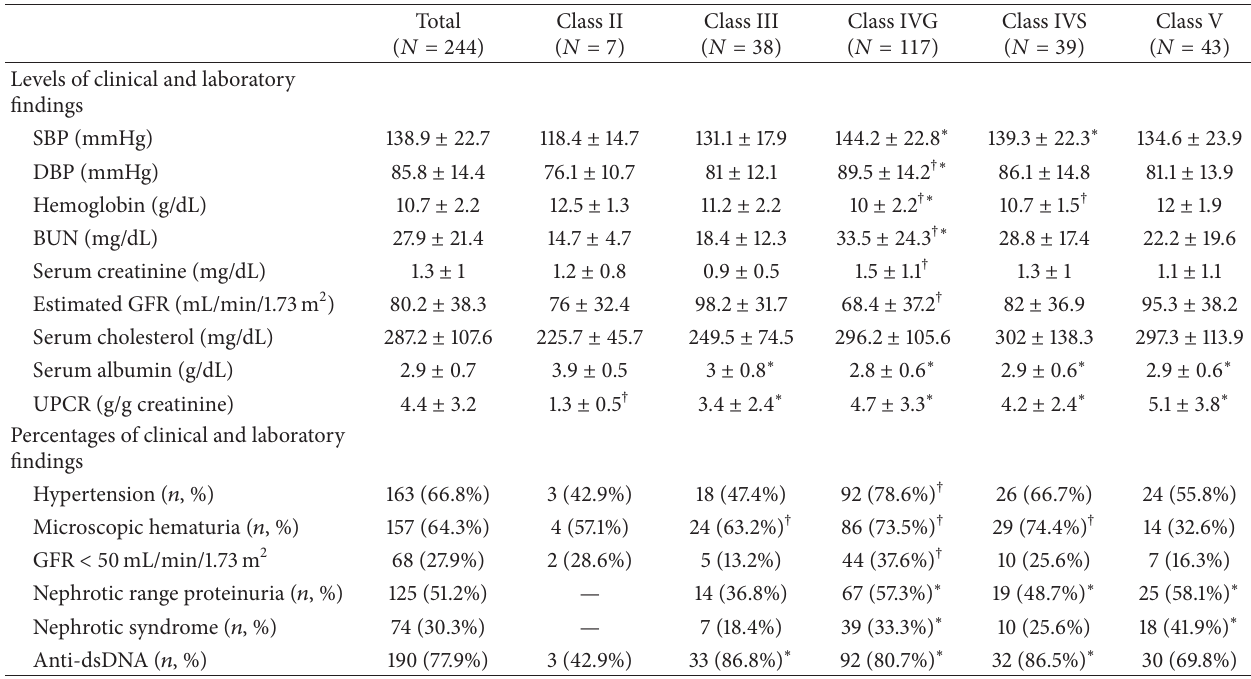
Table 2: Renal findings at renal biopsy by LN